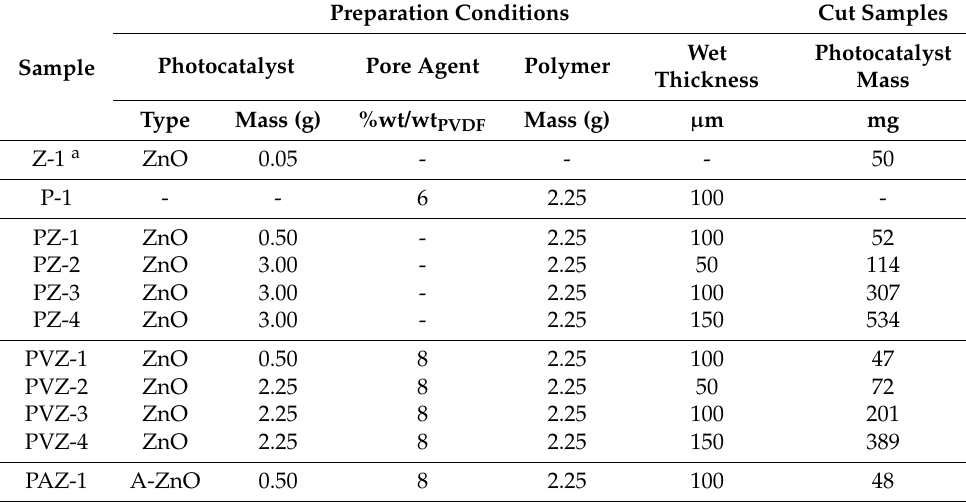
Table 1. Catalyst films preparation compositions and photocatalyst mass of cut